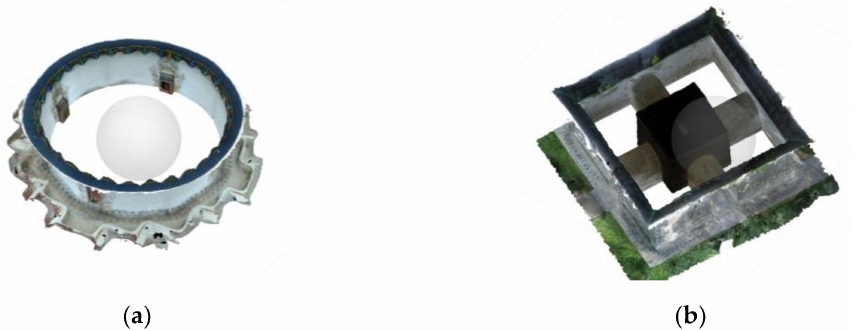
Figure 6. Textured mesh model with recovered frame positions of the two datasets. ( a ) B 30 of the Stupa; and ( b ) B 30 of the